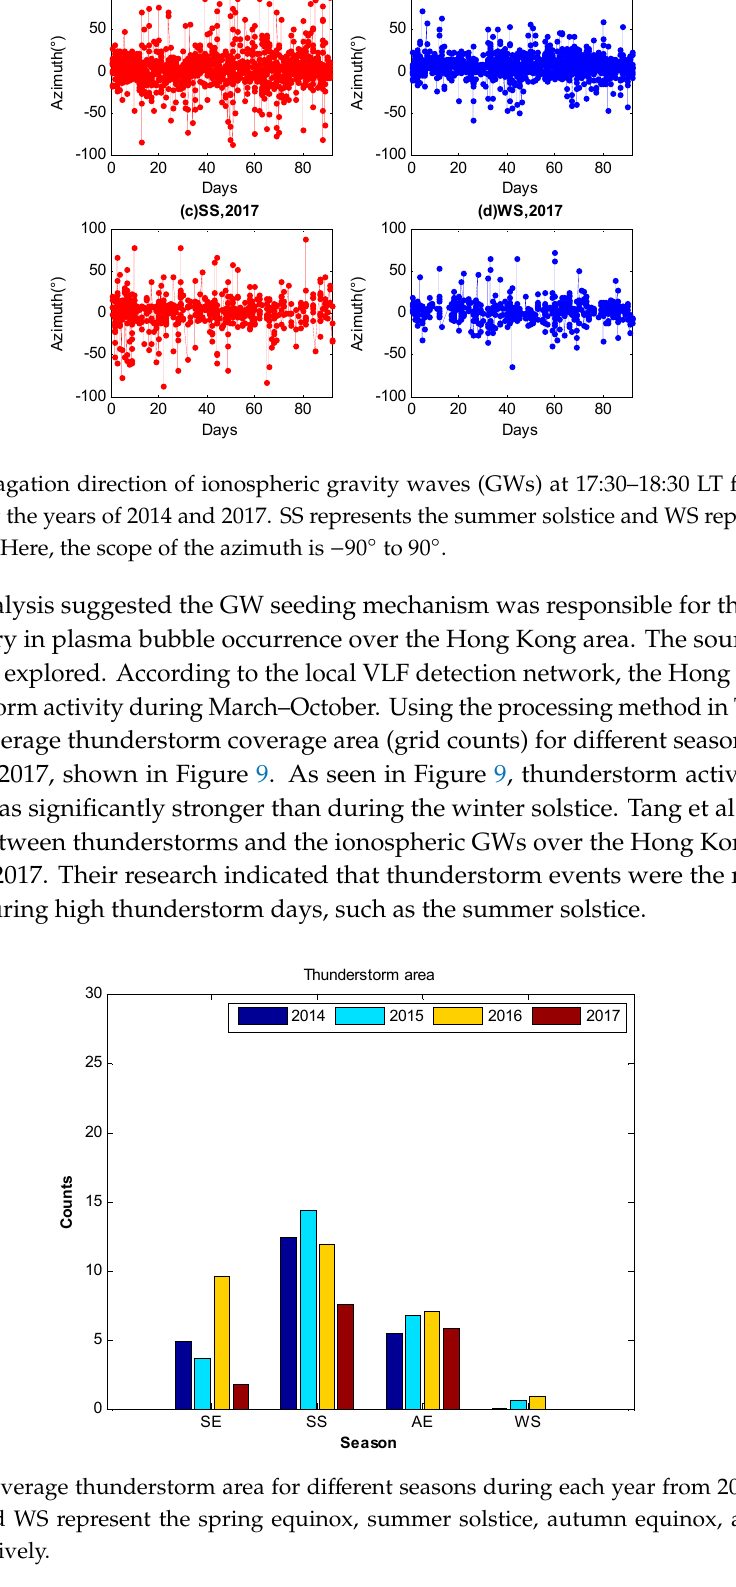
Figure 7. Ionospheric detrended TEC (dTEC) series extracted by GNSS station HKKT during the years of 2014 and 2017.